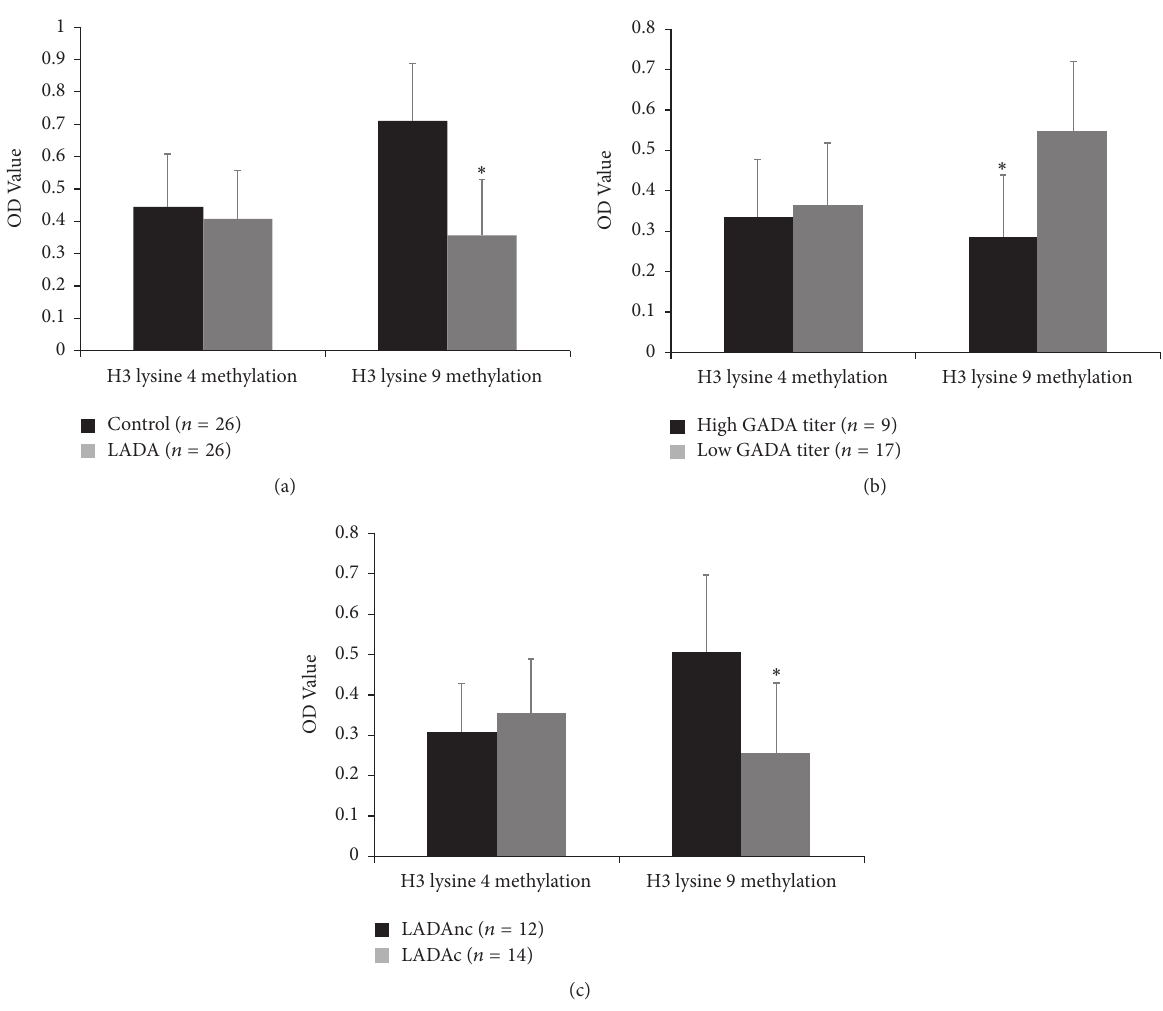
Figure 2: Reduced H3 lysine 9 methylation level in LADA patients. (a) Global H3 lysine 4 and H3 lysine 9 methylation level in CD4 + T lymphocytes from 26 LADA patients and 26 healthy controls, ∗ 𝑃 < 0.05 , LADA patients versus healthy controls. (b) Global H3 lysine 4 and H3 lysine 9 methylation level in CD4 + T lymphocytes from LADA patients, ∗ 𝑃 < 0.05 , LADA patients with low GADA titer ( 𝑛 = 17 ) versus LADA patients with high GADA titer ( 𝑛 = 9 ). (c) Global H3 lysine 4 and H3 lysine 9 methylation level in in CD4 + T lymphocytes from LADA patients, ∗ 𝑃 < 0.05 , LADA patients with complications (LADAc, 𝑛 = 14 ) versus LADA patients without complications (LADAnc, 𝑛 = 12